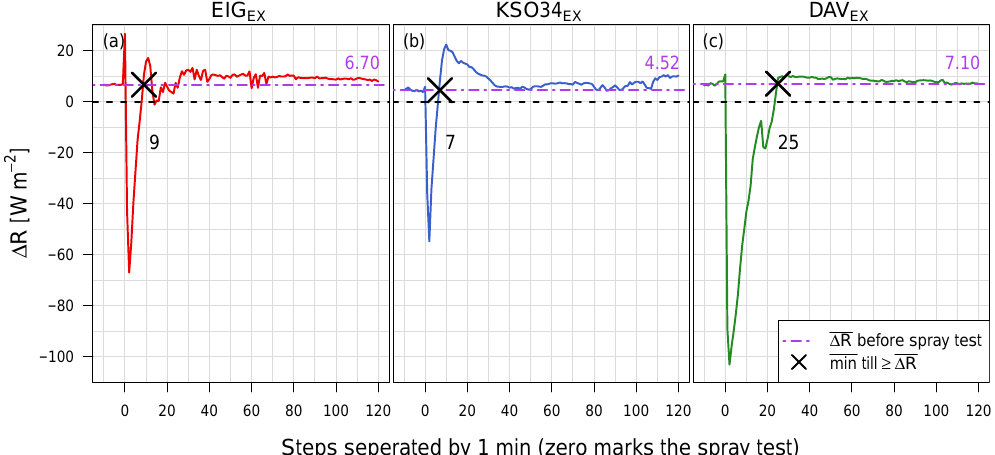
Figure 8. Difference in radiation ( (cid:49)R ) between the individual experimental pyranometer/HV-system combinations and the reference pyra- nometer (REF) with an 1min resolution during daytime for (a) EIG EX , (b) KSO34 EX , and (c) DAV EX . The x axis shows time, starting 10min before and ending 120min after the spray tests (marked with zero). The purple dot–dashed horizontal line marks the average dif- ference (cid:49)R before the spray test, and the black cross marks the average time in minutes which each pyranometer/HV-system combination needed to return to or exceed its initial state. Note that these experiments were not performed in parallel for technical